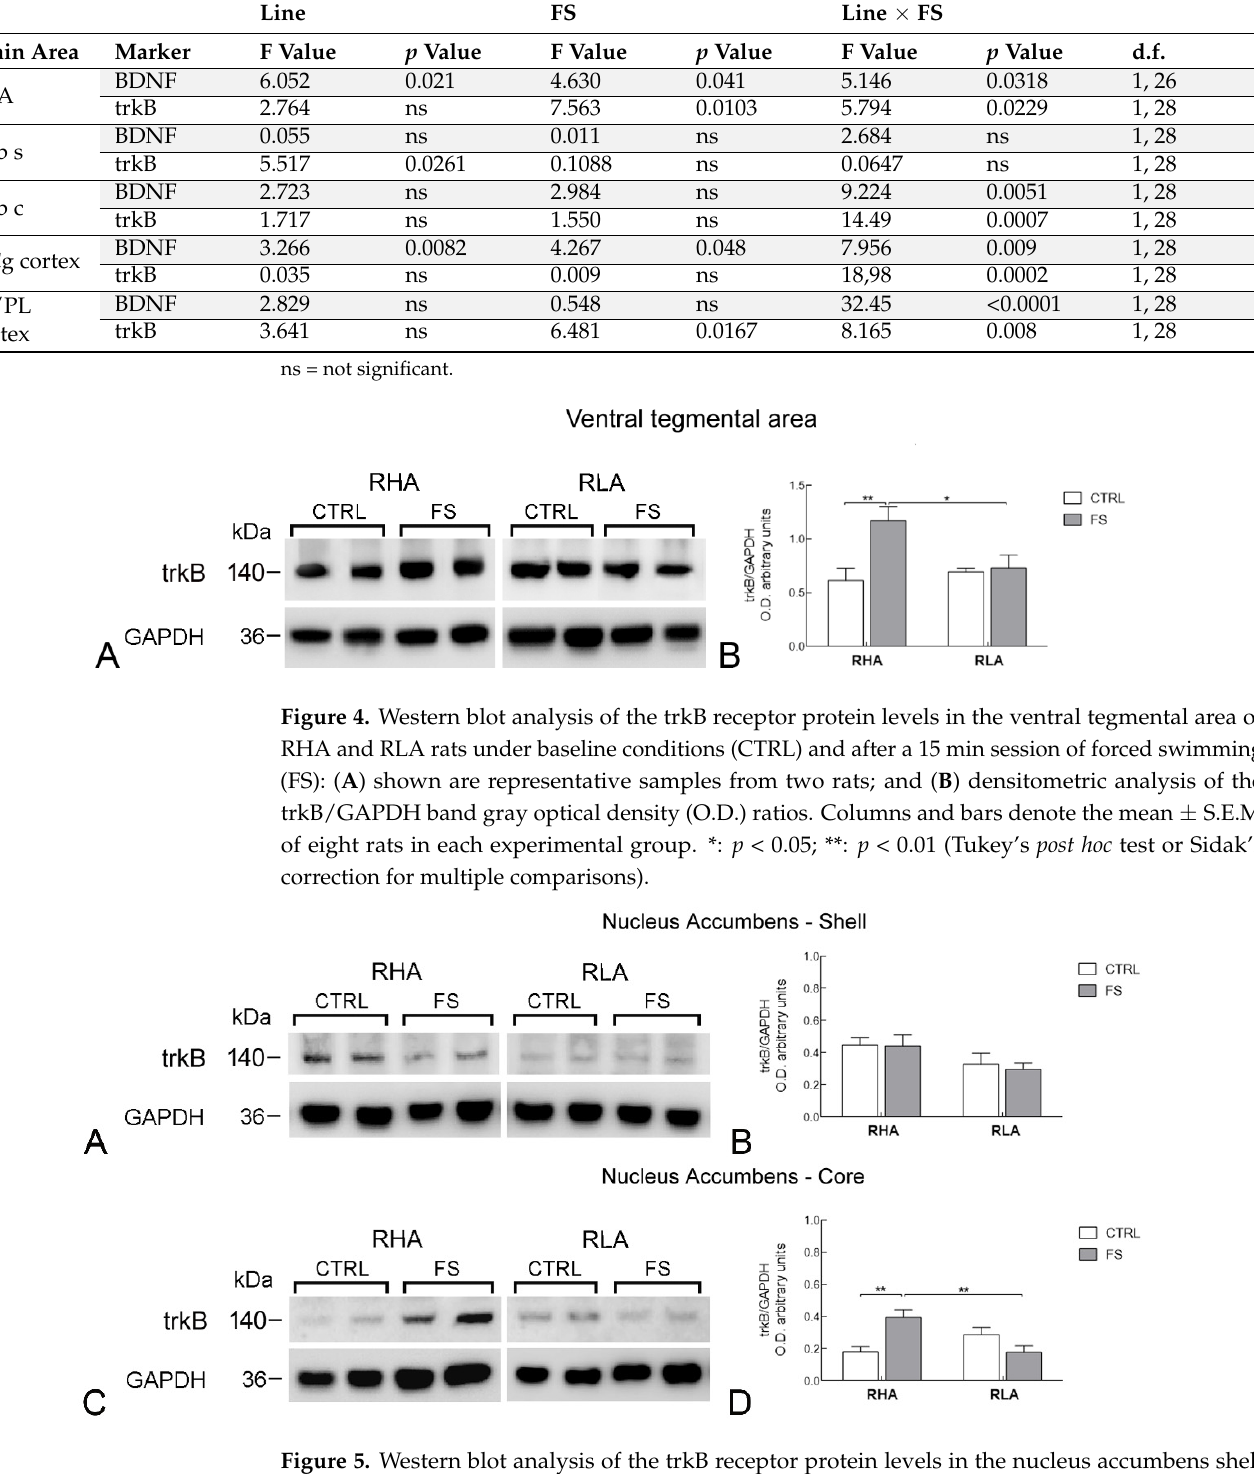
Figure 5. Western blot analysis of the trkB receptor protein levels in the nucleus accumbens shell ( A , B ); and core subregions ( C , D ) of RHA and RLA rats under baseline conditions (CTRL) and after a 15 min session of forced swimming (FS). ( A , C ) shown are representative samples from two rats; and ( B , D ) densitometric analysis of the trkB /GAPDH band gray optical density (O.D.) ratios. Columns and bars denote the mean ± S.E.M. of eight rats in each experimental group. **: p < 0.01 (Tukey’s post hoc test or Sidak’s correction for multiple comparisons).